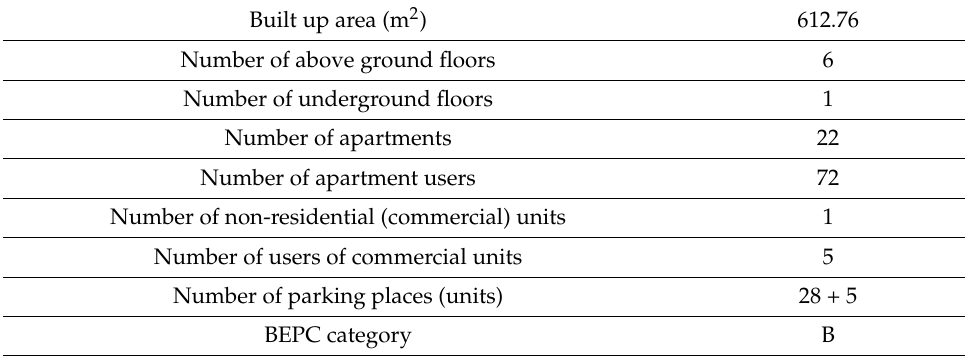
Table 3. Building basic data.